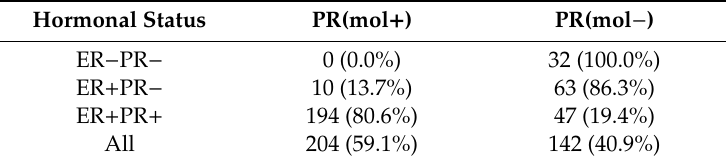
Table 4. Reclassification of cases using the PR-molecular signature (PR(mol)). Data presented as numbers and percentages in brackets. ER—estrogen receptor status, PR—progesterone receptor; p < 0.001, Pearson’s chi-squared